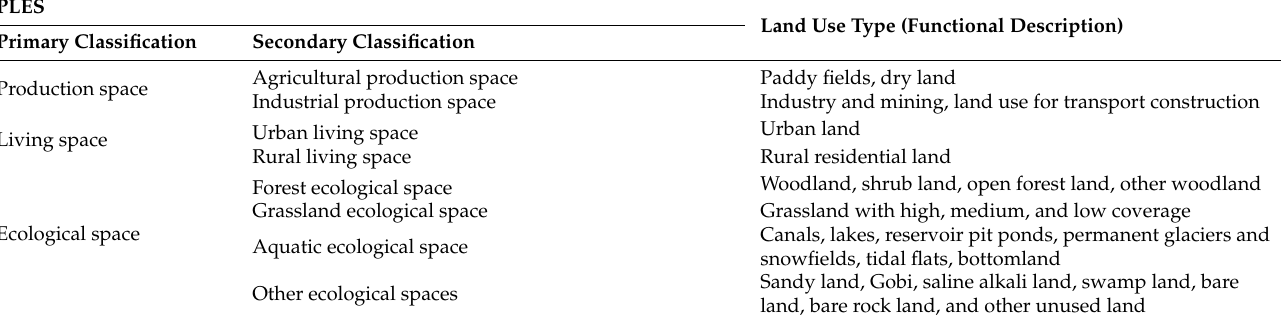
Table 1. PLES spatial classification